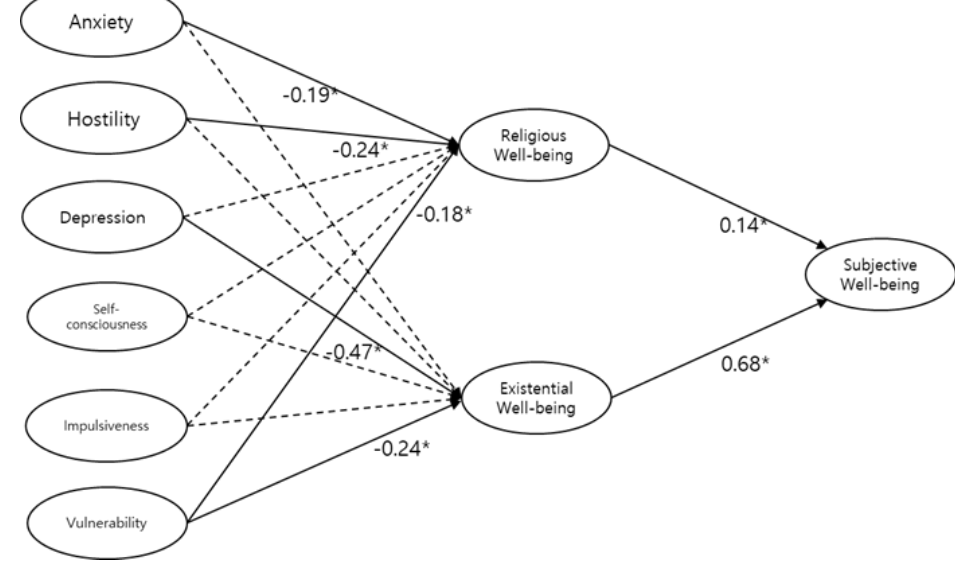
Figure 1. The structural equation model depicting the mediating effect of spiritual well-being on the association between subfactors of neuroticism and subjective well-being. Note. * p < 0.05.